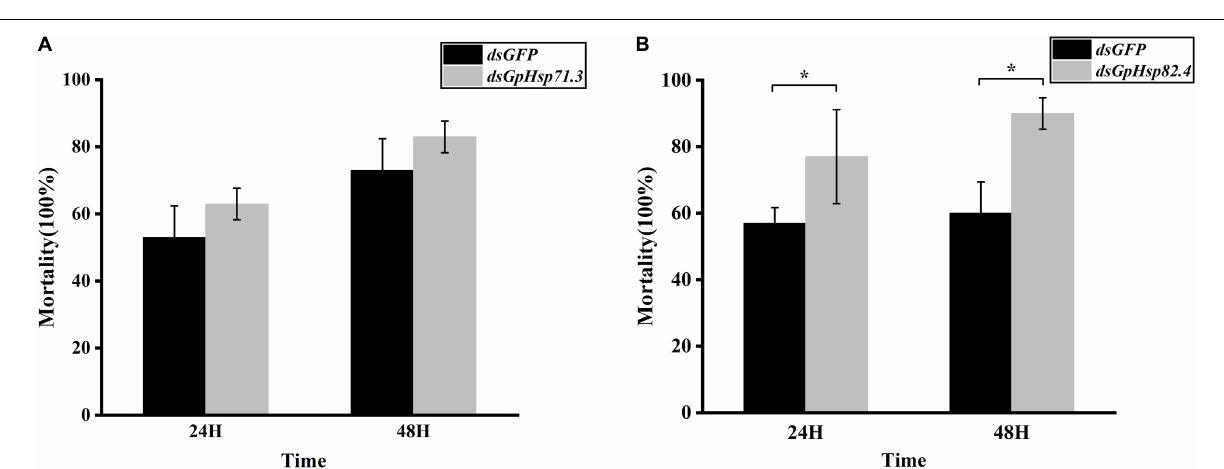
FIGURE 10 | Mortality of G. pyloalis larvae to temperature stress after RNAi for 24/48 h. (A) GpHsp71.3 ; (B) GpHsp82.4 . Reduction in heat tolerance of G. pyloalis injected with dsRNA and then exposed to 40 ◦ C (high temperature stress). Data are shown as the mean ± SE of three biological replicates and each replicate consists of ten individuals. Single asterisks ( p < 0.05) indicate significant differences between dsGFP and dsGpHsp